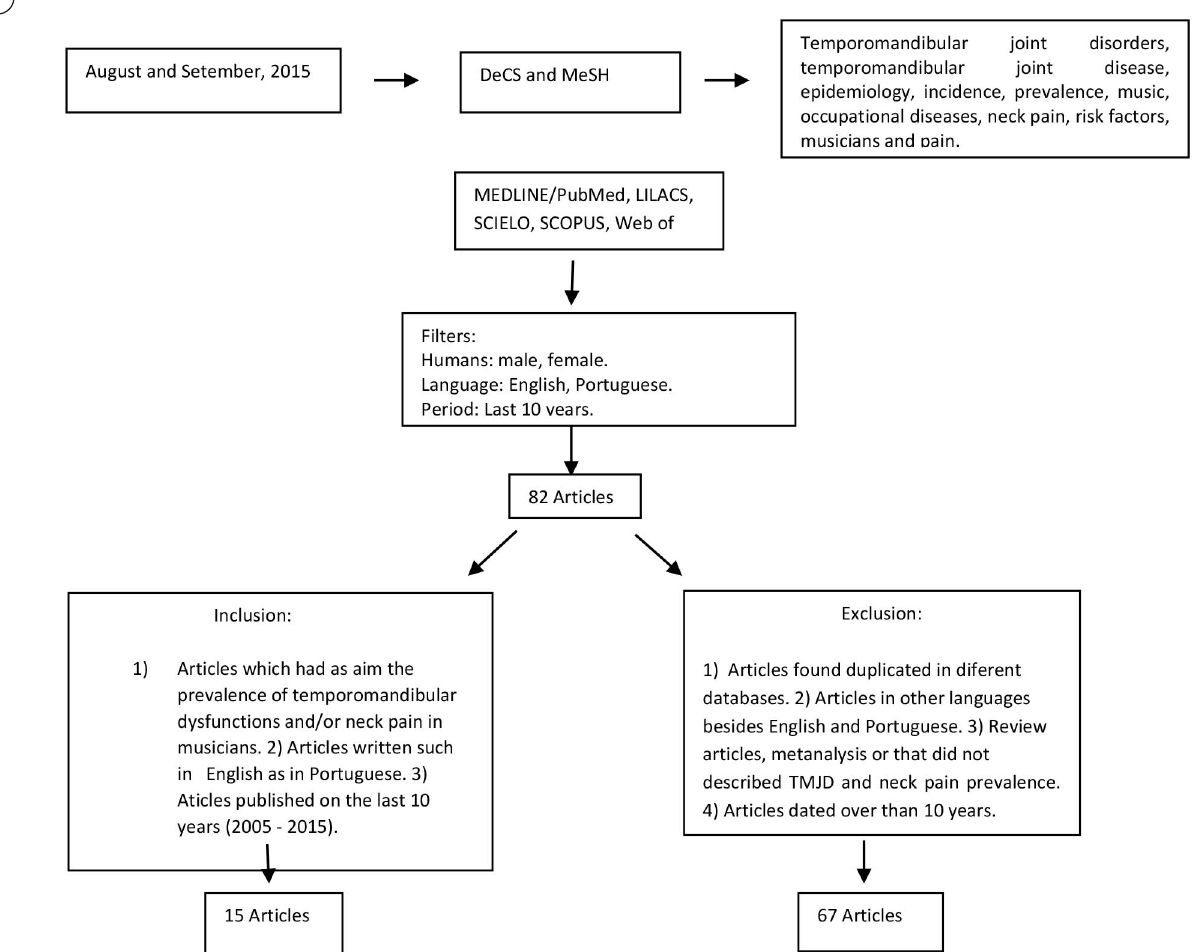
Figure 1 - Flowchart of search and selection of articles.